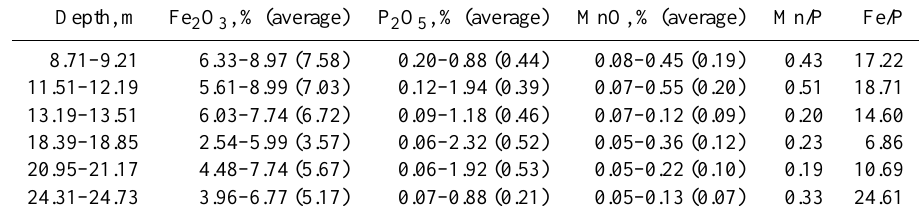
Table 2. Chemical composition of P-Mn rich sediments intervals.